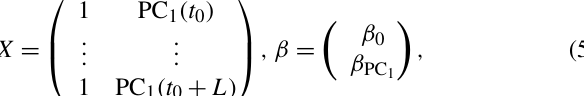
(upper and lower stratosphere) and for each of the